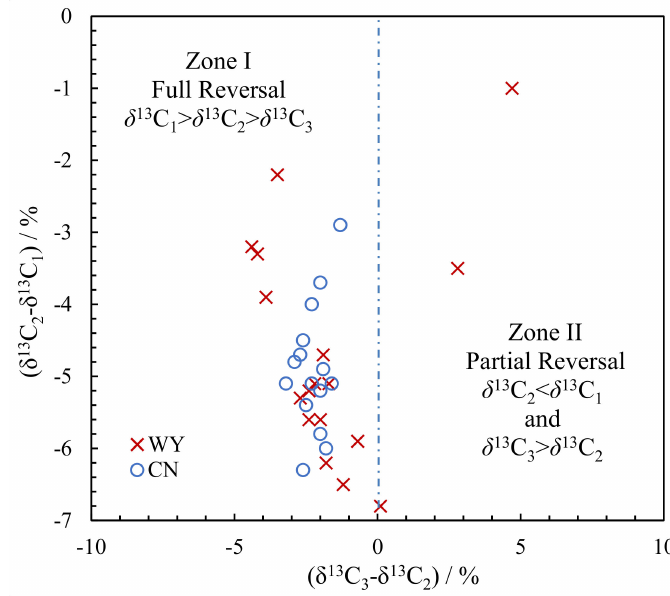
Figure 5. Variation in δ 13 C 2 - δ 13 C 1 as a function of δ 13 C 3 - δ 13 C 2 for gases from the Weiyuan (WY) and Changning (CN) areas, showing the isotope distribution patterns among methane, ethane, and